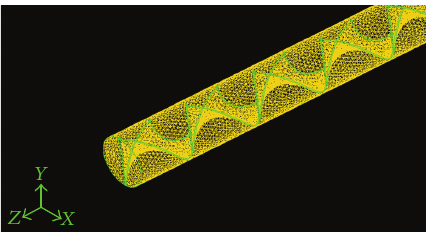
Figure 1: Parabolic-cut twisted insert.